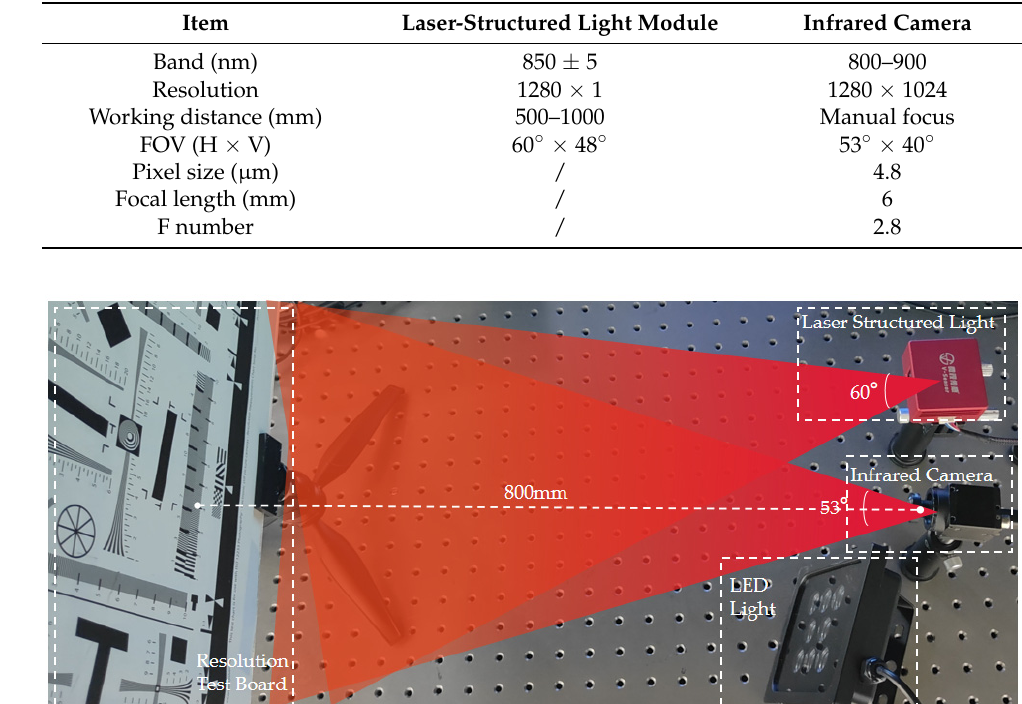
Table 1. Parameters of laser-structured light module and infrared camera.